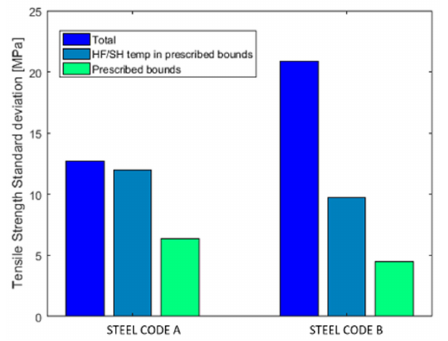
Figure 5. Results of the on-site test concerning the standard deviation of R m .